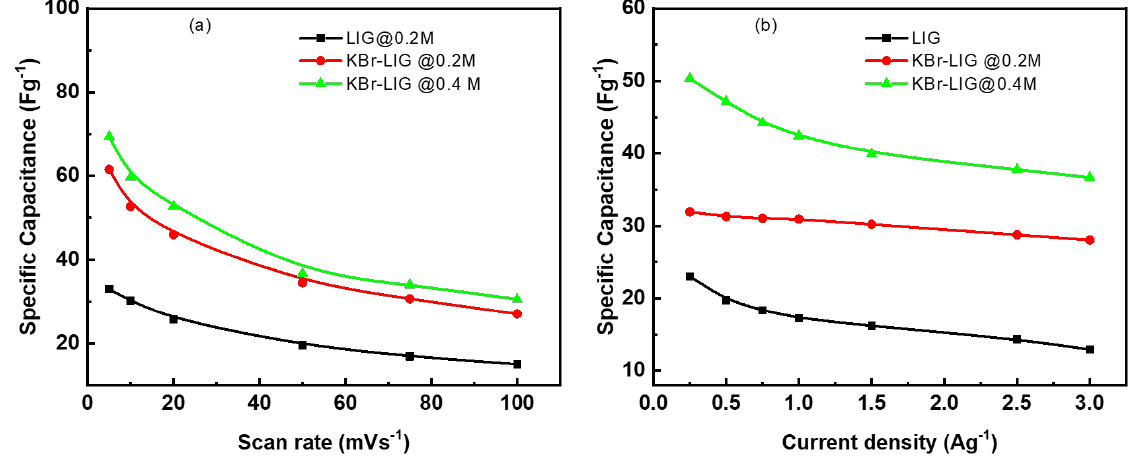
Figure 7. ( a ) specific capacitance as a function of scan rate in mVs −1 , and ( b ) specific capacitance as a function of the current density for pristine LIG, KBr-LIG at 0.2 and 0.4 M of KBrO 3 electrolyte.